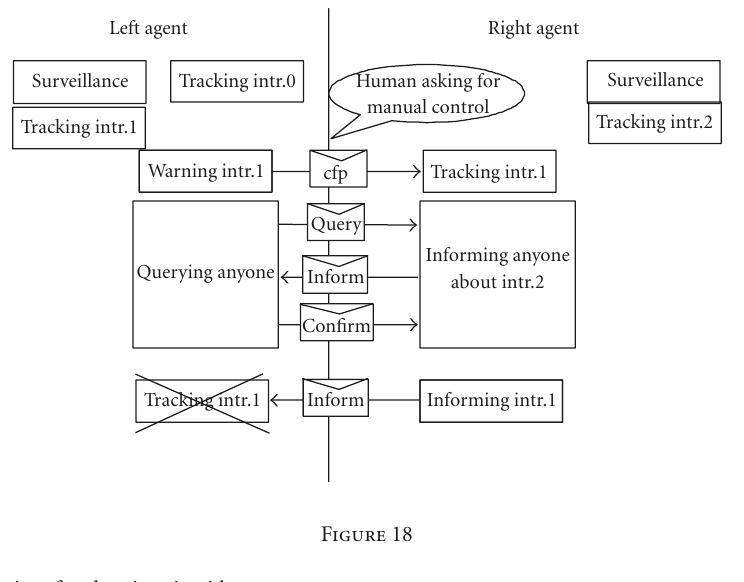
Table 2: Mean velocity of pedestrians in videos. Target ID